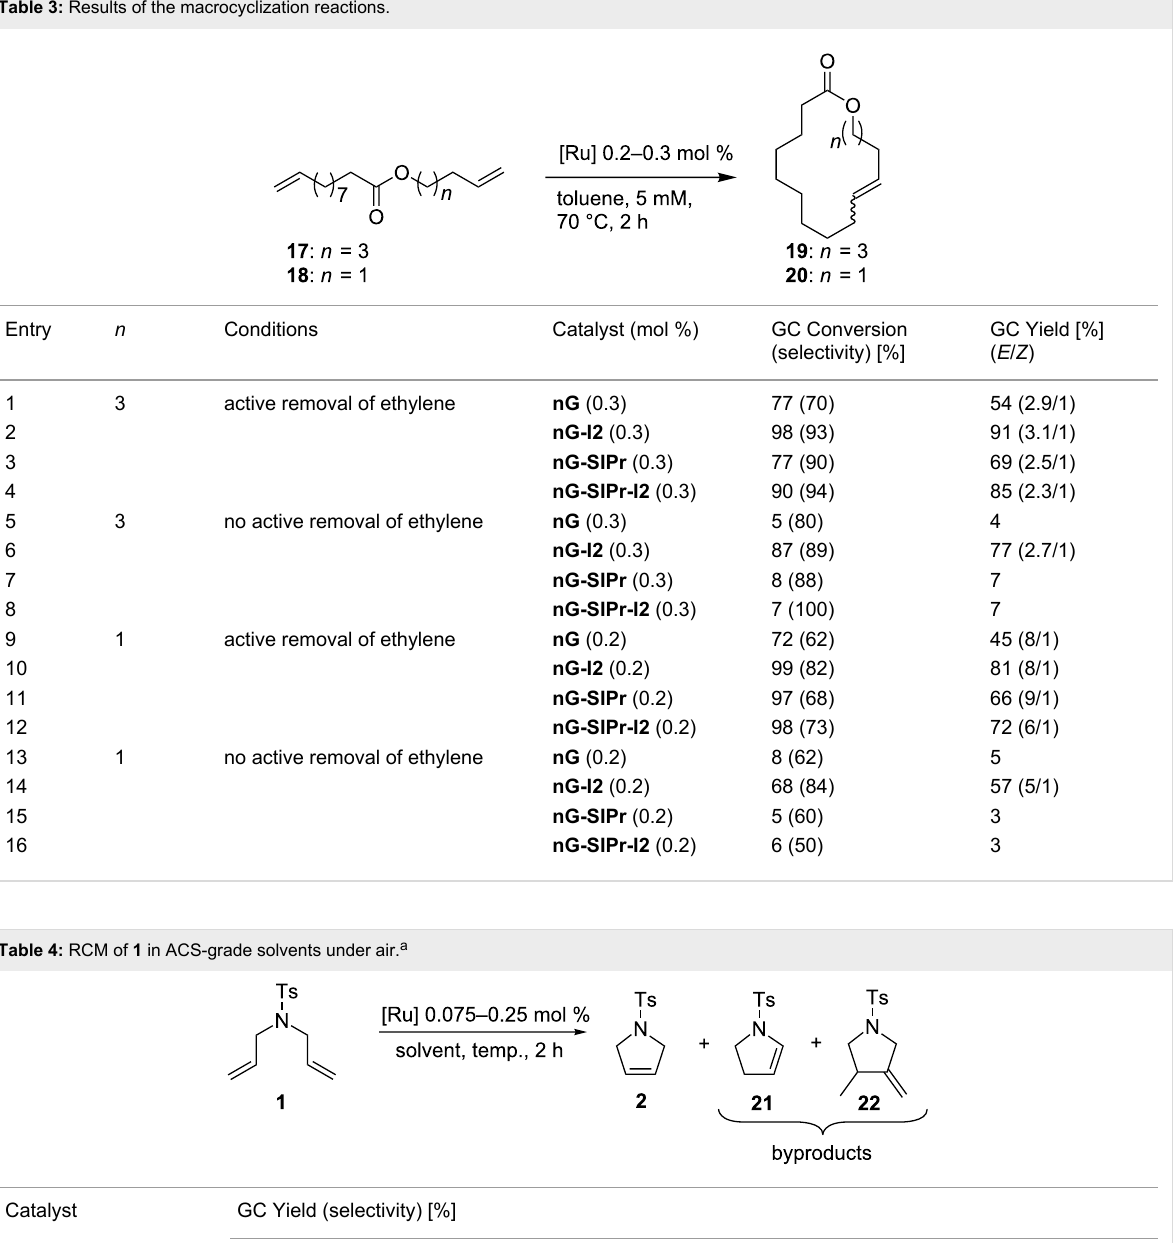
Table 3: Results of the macrocyclization reactions.